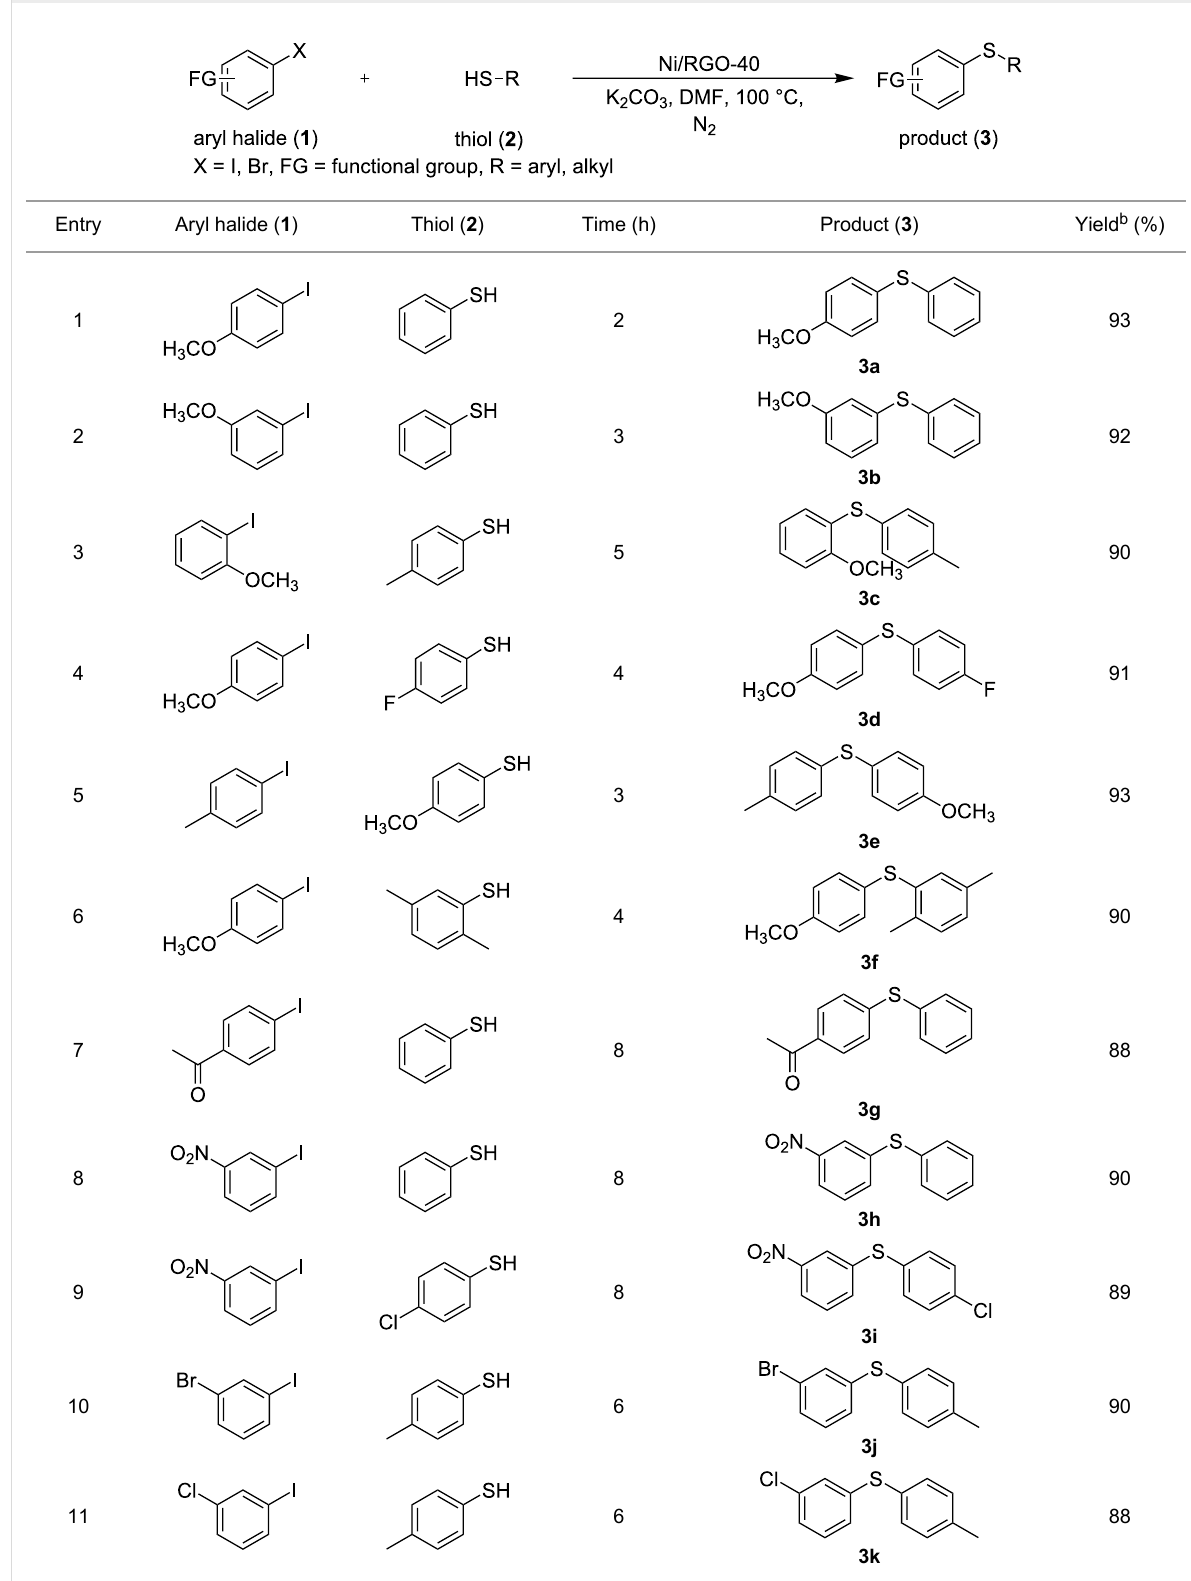
Table 2: Ni/RGO-40 catalyzed C–S cross-coupling between aryl halide and thiol.